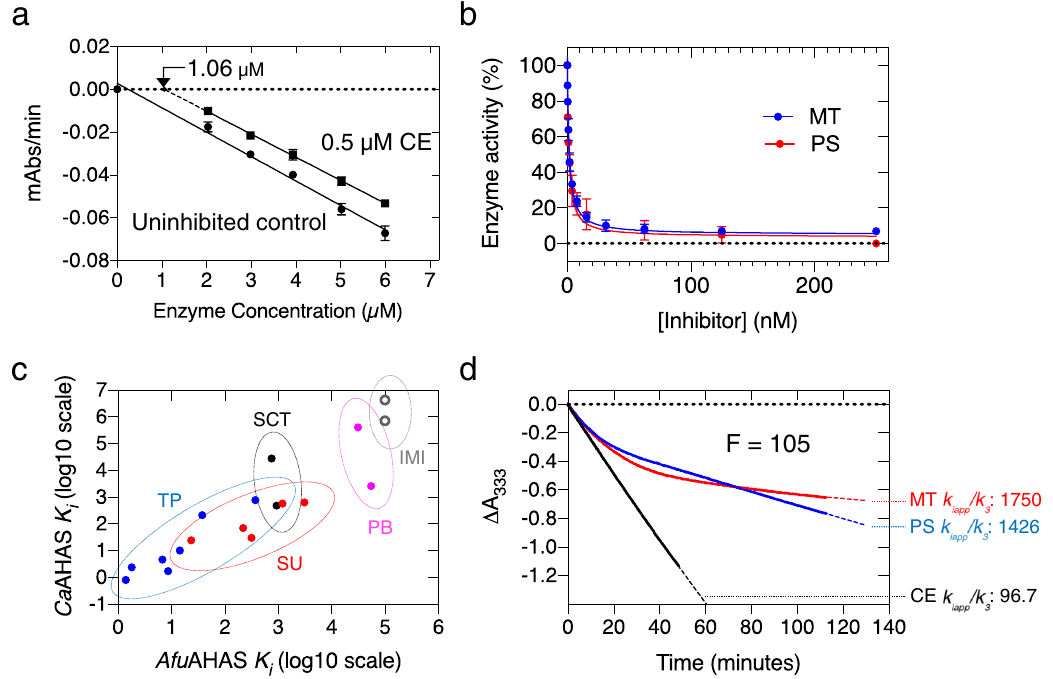
Figure 3. Inhibition of Afu AHAS by commercial herbicides. ( a ) Measurement of Afu AHAS activity in the presence and absence of 0.5 µM CE to determine herbicide binding stoichiometry. Extrapolation of the linear regression line (dashed line) showed that 1.06 µM of enzyme was fully inhibited by 0.5 µM CE. ( b ) Afu AHAS catalytic activity vs. inhibitor concentration. The data were fitted using Eq. (1) (see “Materials and methods”) for tight binding inhibitors. ( c ) Correlation of K i values between Afu AHAS and Ca AHAS for the five AHAS herbicide families. TP: Triazolopyrimidines, SU: Sulfonylureas, SCT: Sulfonylamino-carbonyl-triazolinones, PB: Pyrimidinyl-benzoates, IMI: Imidazolinones. d. Accumulative inhibition curves for PS, MT and CE. The data were fitted using Eq. (3) (dashed line). For a direct comparison of the strength of accumulative inhibition, the F value (free enzyme/enzyme-inhibitor complex ratio) was set to 105 for the three inhibitors. The data show that MT is the most potent accumulative inhibitor. Images were created using GraphPad Prism